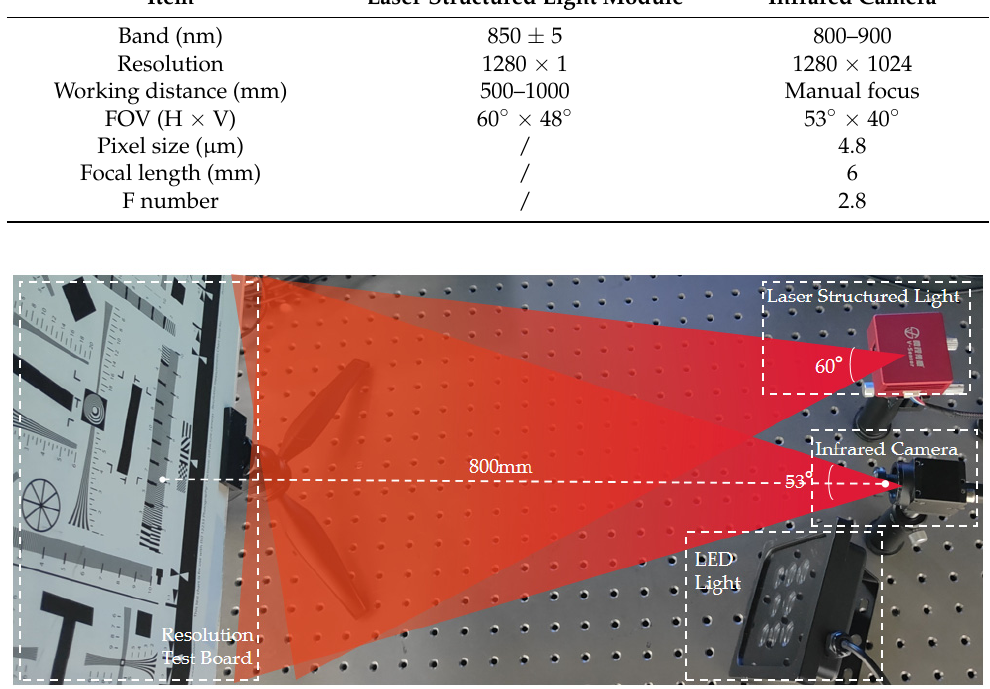
Figure 2. Laser image acquisition system can acquire laser image with speckle noise.